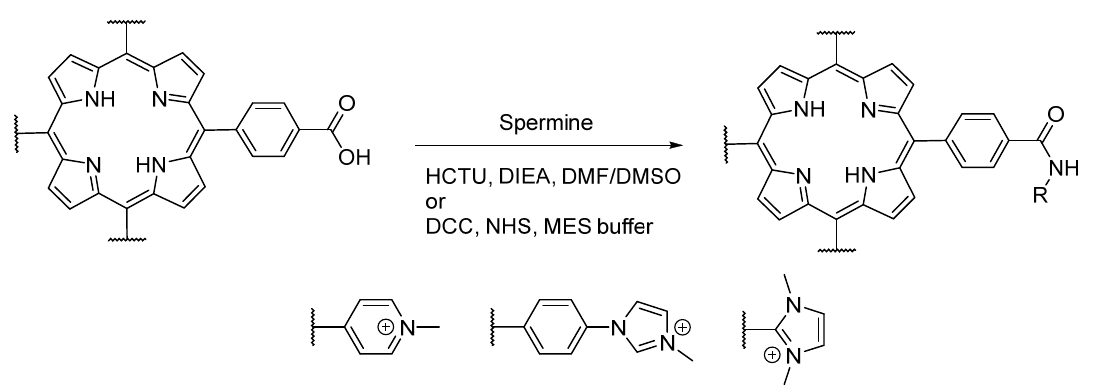
Figure 2. Investigation of carboxylic acid reactivities of cationic porphyrins using coupling agents.